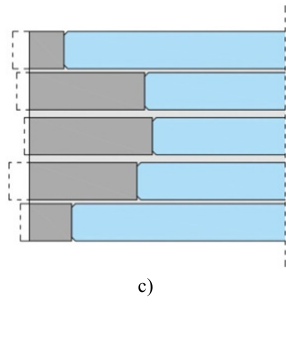
Fig. 1 Examples of edge-integrated